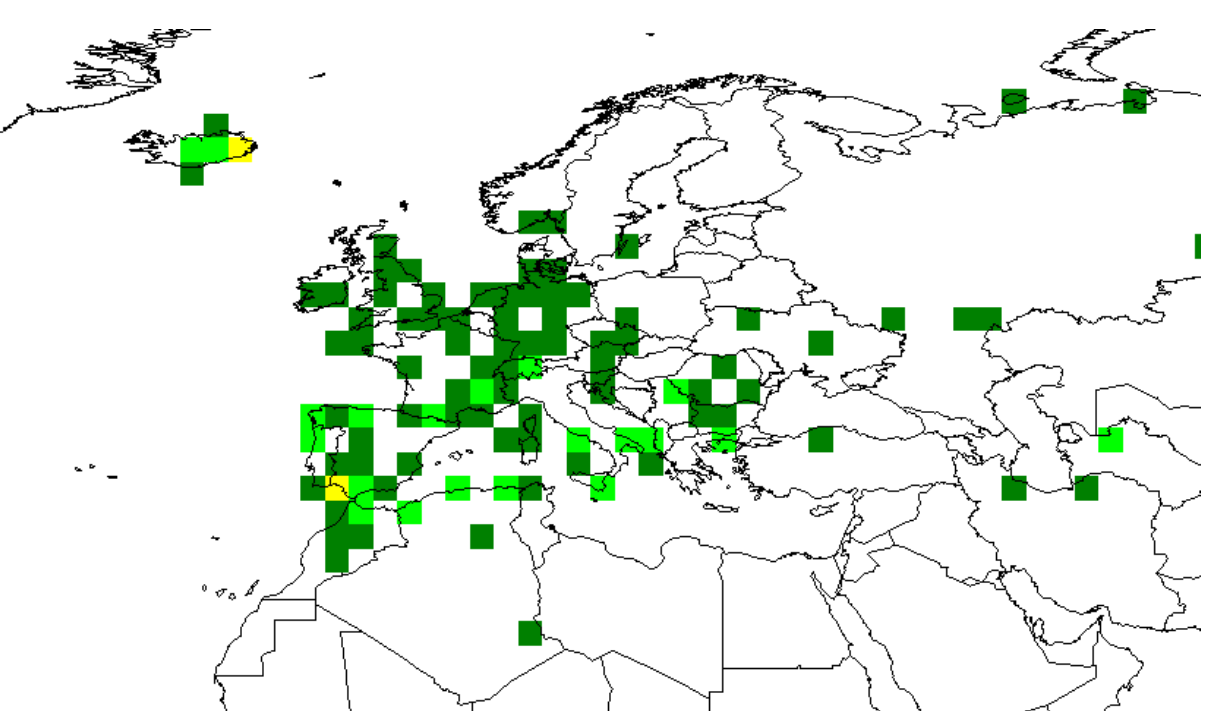
Figure 12. Centers of diversity (main massings) of the species of Diaptomus included in this study. Yellow: three species, light green: two species, dark green: one